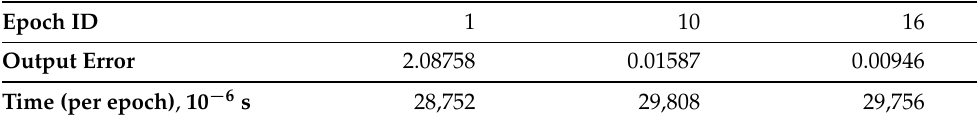
Table 3. Computation complexity and performance of the ANN training